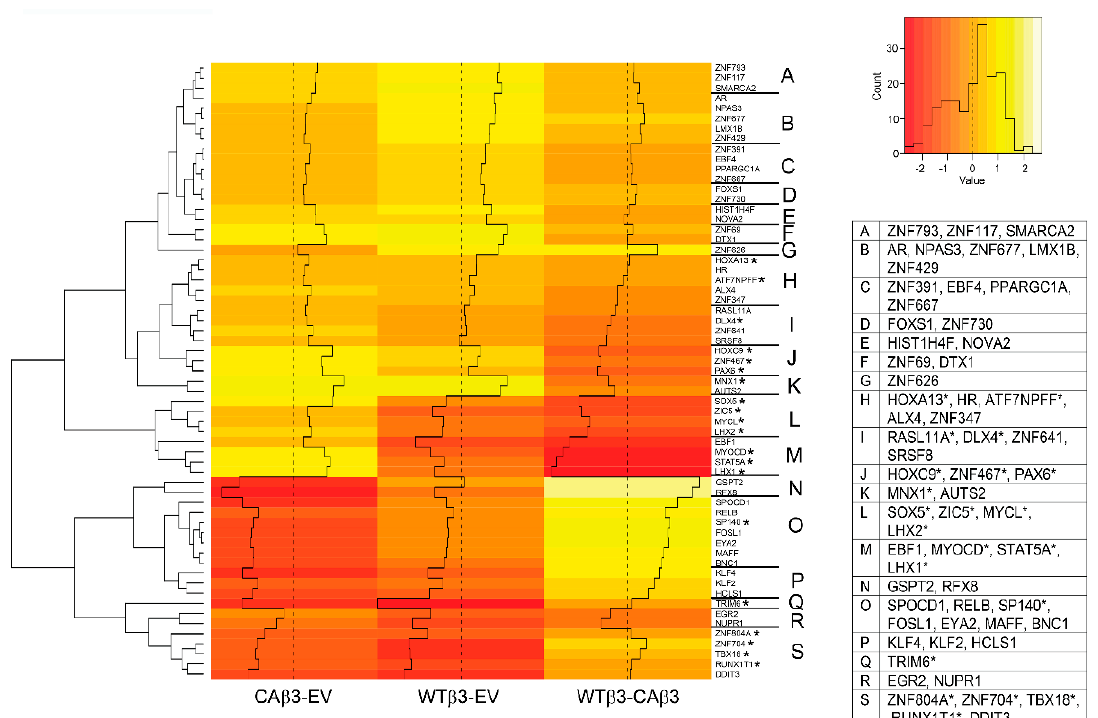
Figure 4. Hierarchical clustering of transcription-associated genes finds differential gene expression in WT β 3 and CA β 3 cells relative to control EV cells and to each other. Genes from each of the three contrasts analyzed for DGE that met the Log 2 FC ± 1.5 cutoff and were classified as either transcription factors, or otherwise part of the transcription process were analyzed using R statistical computing and graphics software. A heat map displaying standardized z-scores was generated. The clusters identified by letters on the right side of the map were determined manually. Genes within each of these clusters are listed in the displayed table. Those genes highlighted by an asterisk represent genes that had been excluded from the initial DGE analysis due to low abundance in the read count in two or more samples of one of the three cell lines. To be included in the heat map, the missing Log 2 FC values were calculated from the raw count data using Excel. To be consistent, the corresponding Log 2 FC values for the same gene in the other two cell lines were re-calculated from the raw data as well. These values were then converted to standardized z-scores along with the other genes using R.